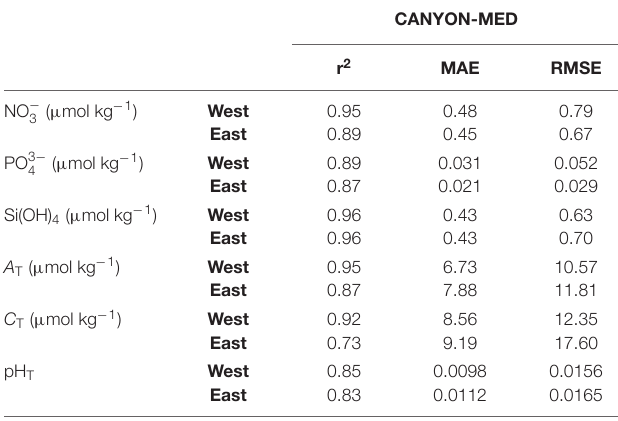
TABLE 6 | Statistics between the CANYON-MED retrieved values and the corresponding in situ measurements on the validation database according